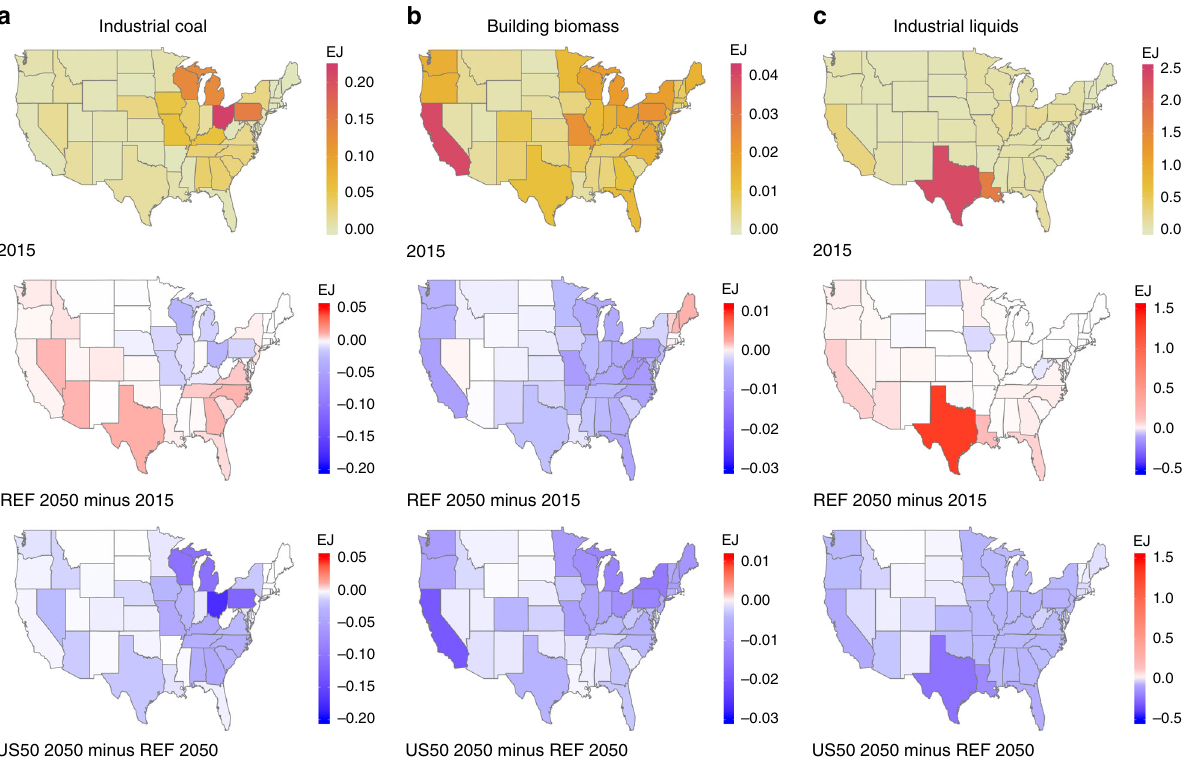
Fig. 5 Regional actions of reducing PMMC. The fi rst row shows 2015 estimates of energy consumption in three high-emission-intensity sources — industrial coal ( a ), building biomass ( b ), and industrial liquids ( c ) for continental US states. The second row shows energy consumption changes for high- emission-intensity sources in 2050 compared with 2015, and the third row shows energy consumption changes in US50 relative to REF in 2050, as actions of reducing PMMC. Blue indicates reduced energy use in high-emission-intensity sources, and red indicates increased energy use in high-emission- intensity sources. Source data are provided as a Source Data fi